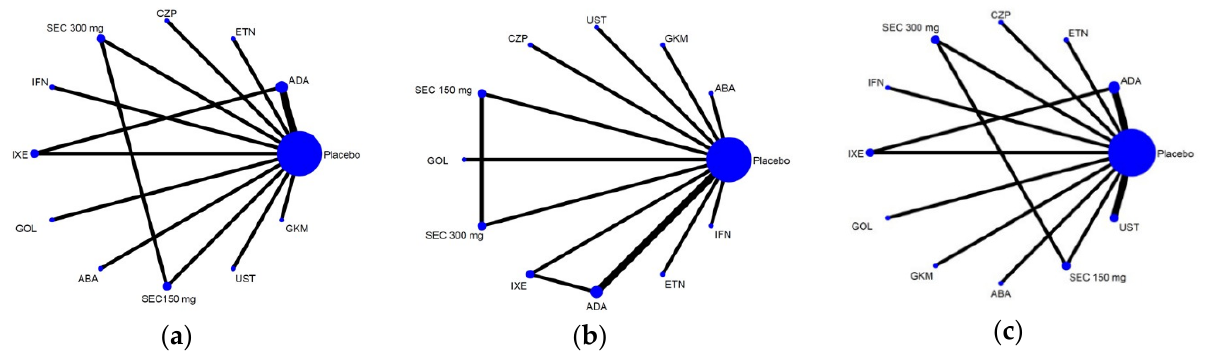
Figure 2. Geometric structure for efficacy and safety. ( a ) Radiographic non-progression; ( b ) change in the total radiographic score; ( c ) discontinuation due to adverse events. PBO: placebo; IFN: infliximab; ADA: adalimumab; UST: ustekinumab; GOL: golimumab; ABA: abatacept; SEC: